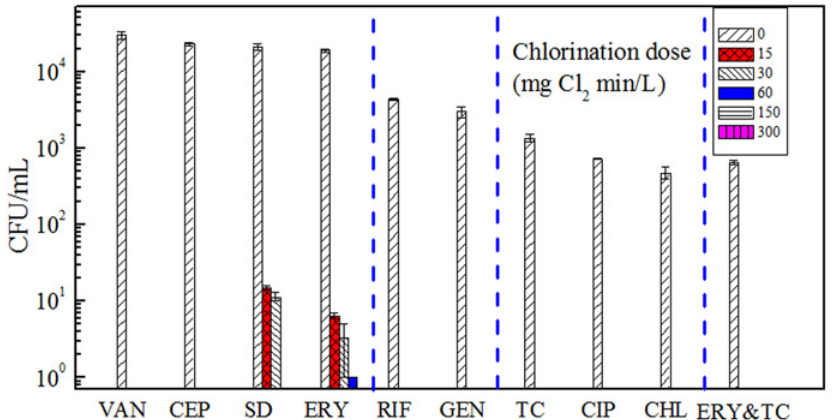
Fig 2. Heterotrophic bacteria resistant to nine antibiotics after different doses of chlorination. VAN, CEP, SD, ERY, RIF, GEN, TC, CIP, CHL and ERY&TC represent. vancomycin-, cephalexin-, sulfadiazine-, erythromycin-, rifampicin-, gentamicin-, tetracycline-, ciprofloxacin-, chloramphenicol and erythromycin & tetracycline- resistant bacteria, respectively. Error bars indicate standard deviation for replicates from a single